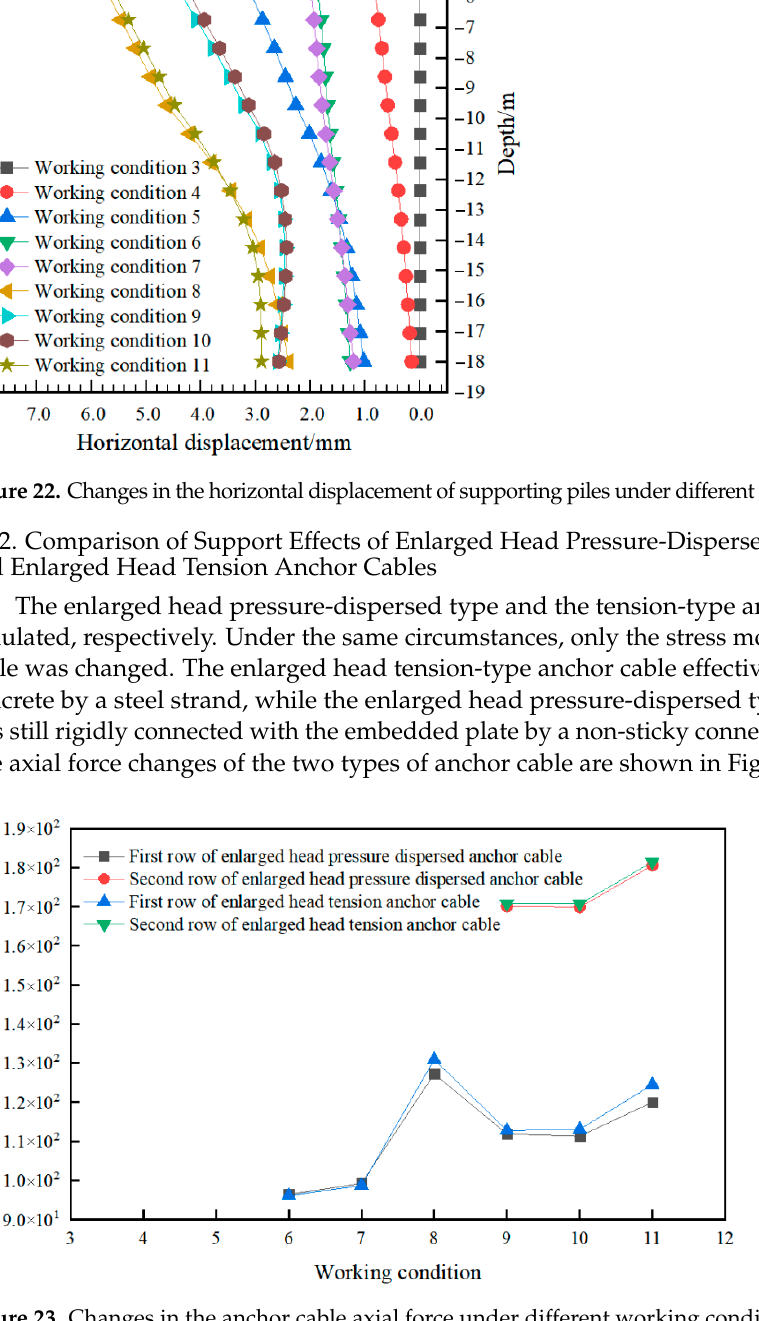
Figure 21. Final horizontal displacement cloud image.